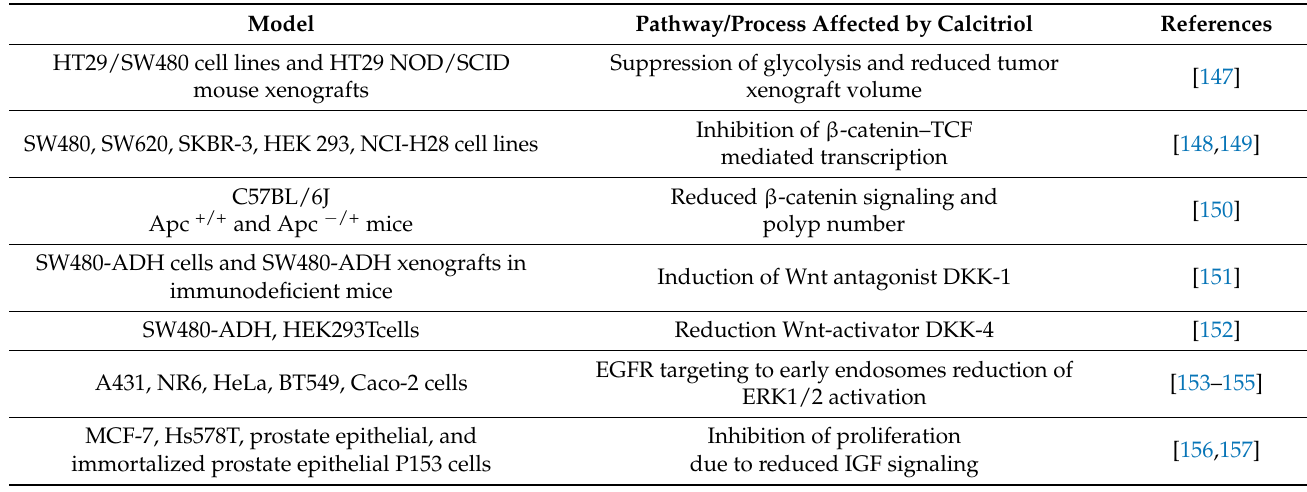
Figure 5. Calcitriol and HIF-1/2 cross-talking in hallmarks of cancer. HIF-1/2-mediated transcription governs essential processes implicated with adaptation to the hypoxic microenvironment of solid tumors and promotes cancer progression. There is accumulating evidence that calcitriol interferes with these particular events and opposes the advancement of the malignant phenotype, rendering calcitriol or its analogs promising agents for chemoprevention and treatment. A distinguishing characteristic of cancer cells is the upregulation of glycolysis to sustain energy and generate biomass. This switch to anaerobic metabolism is greatly enhanced under hypoxia and mediated by HIF activation and subsequent expression of glycolysis-supporting proteins such as GLUT1, HK2, and LDHA [146]. Interestingly, calcitriol significantly impaired the expression of these critical glycolytic proteins in an HT29 subcutaneous xenograft mouse model [147]. Table 1. Signaling pathways or cellular processes affected by calcitriol in various cell- or animal-based